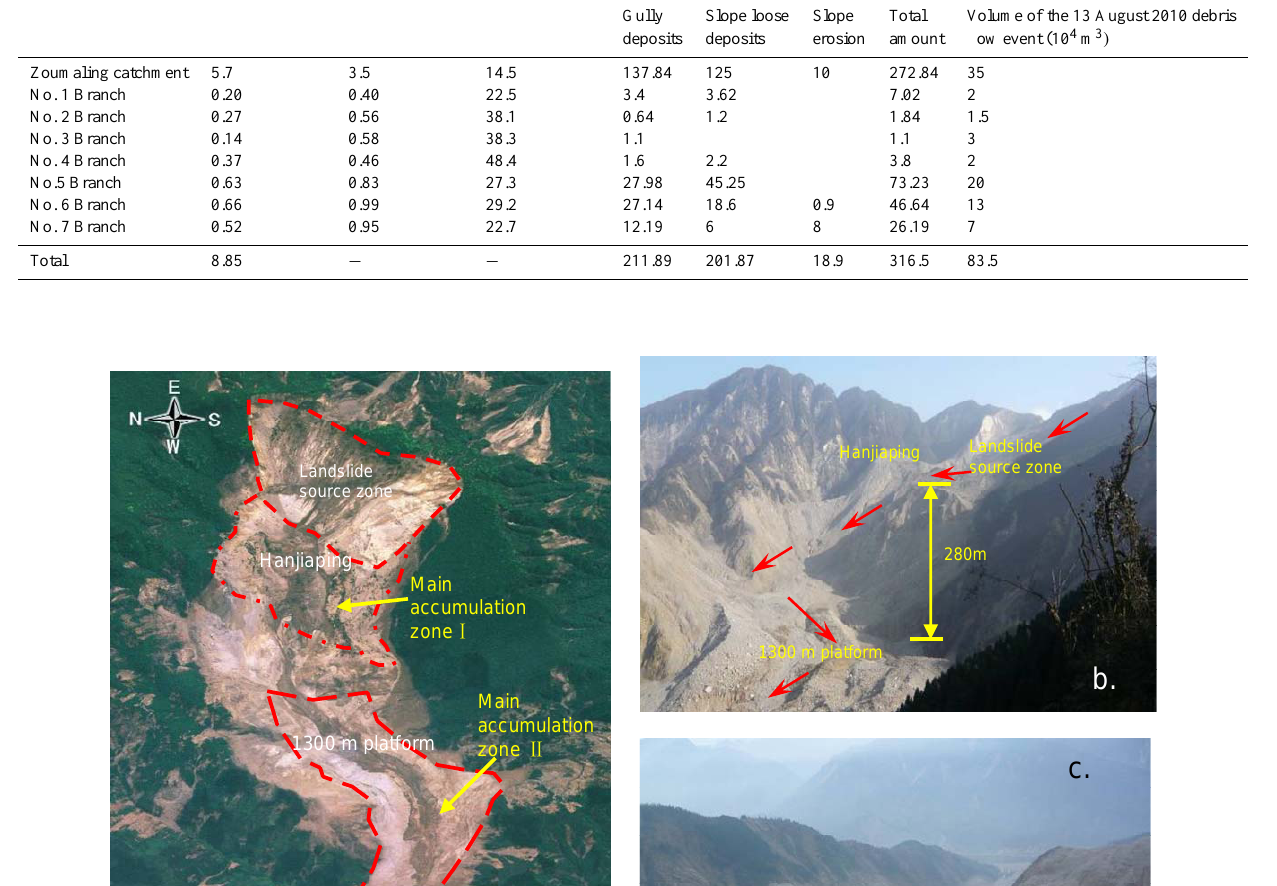
Fig. 5. Section of the Wenjia gully landslide (Huang and Zhao, 2010).